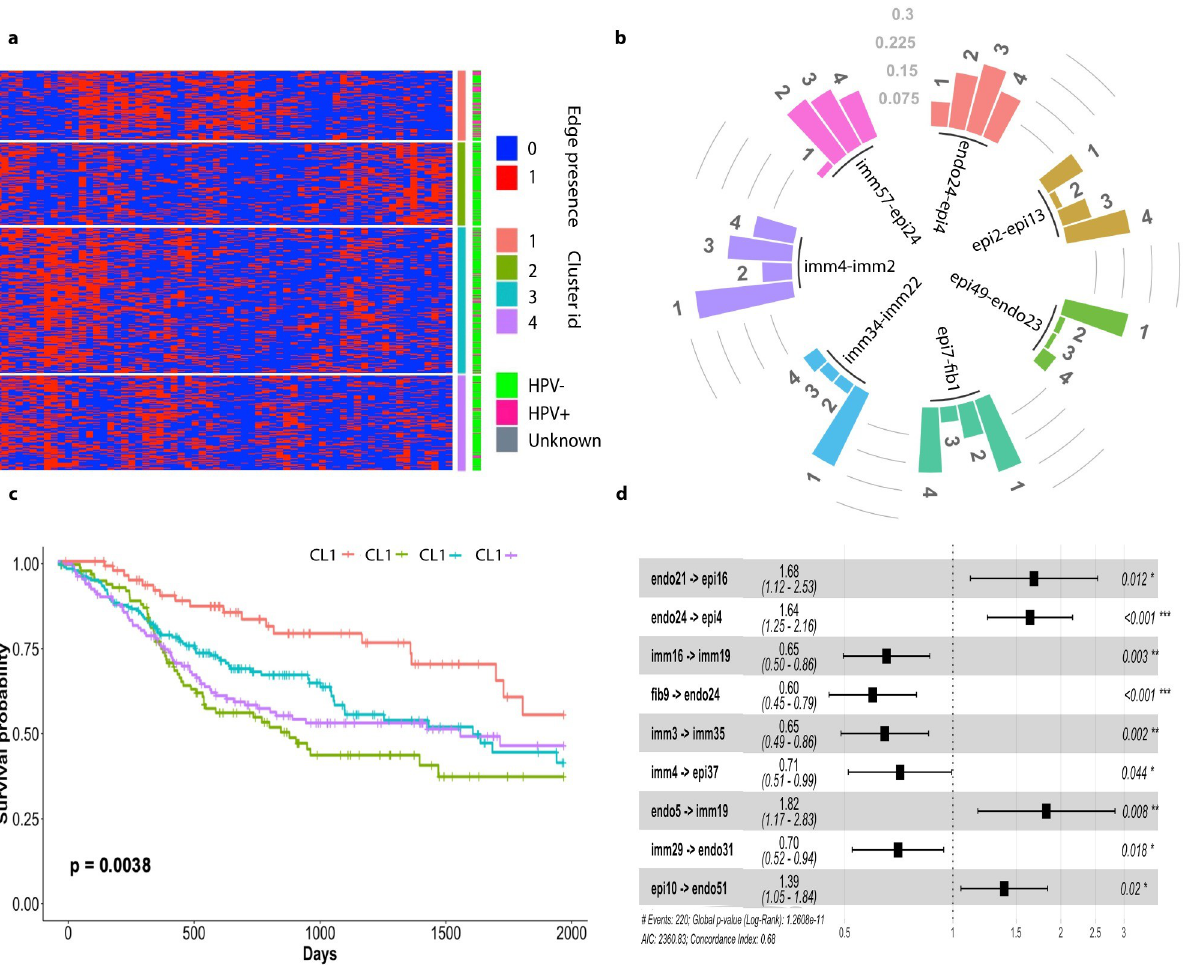
Fig 5. Distinct intercellular communication networks revealed by individualized CBN discovery. a. Clustering of tumor specific intercellular communication networks. Tumor specific causal networks returned by the iGFCI algorithm were represented in the space spanned by the union of edges, where the presence/absence of an edge is represented by a binary variable (“1” / “0” respectively). Tumors (rows) were divided into 4 clusters, and the presence/absence of edges (columns) is shown as a heatmap. b. Examples of causal edges with high variance among tumor clusters. Eight edges are shown, and the directions of the edges are indexed by the cause-effect GEMs. The height of a bar reflects the ratio (or percentage) of tumors in a cluster (indicated by a number from 1 to 4) that have the edge in their tumor specific network. c. Kaplan-Meier survival curves of patients assigned to different clusters. d. A list of the causal edges that are associated with a statistically significant proportional hazard ratios according to a Cox proportional hazard analysis .